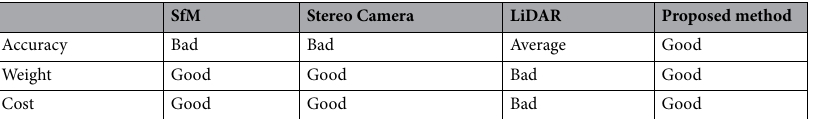
Table 6. Comparison between the proposed and conventional methods/devices structure from motion (SfM) and light detection and ranging